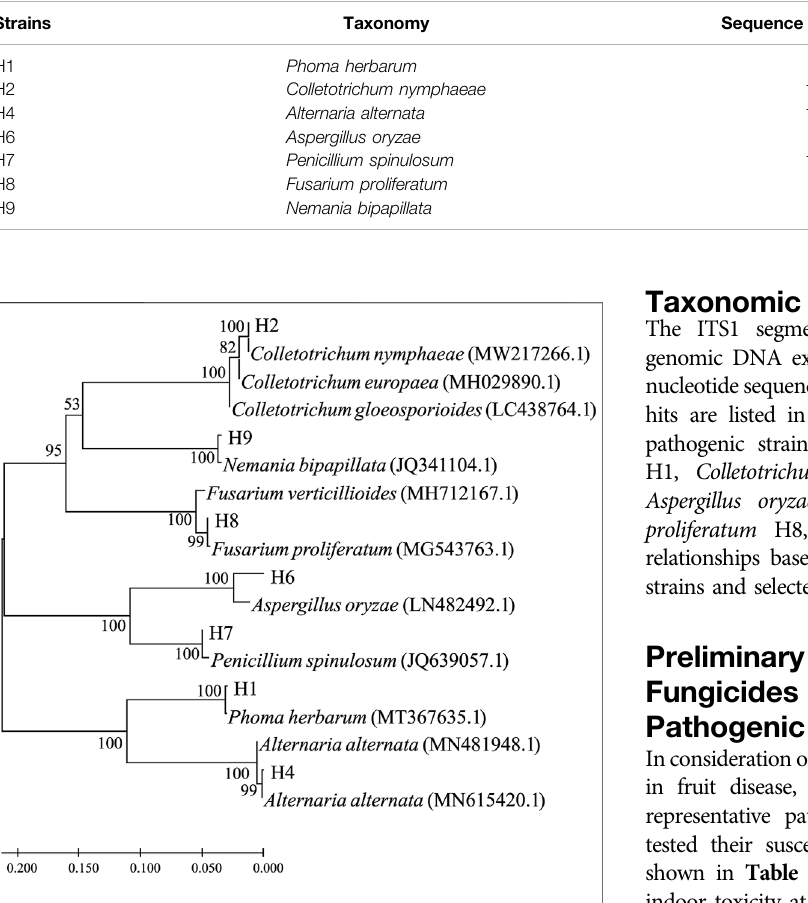
FIGURE 2 | Molecular phylogenetic tree based on the rDNA-ITS sequencesimilarity.Sequencealignmentand treebuildingwereperformedby MEGA5.0 using the neighbor-joining method, and phylogeny was tested by 500 bootstrap replications. The numbers on branches were calculated as bootstrap values. Accession numbers of ITS1 sequences from isolated strains were, namely, ON514545.1 (H1), ON514546.1 (H2),